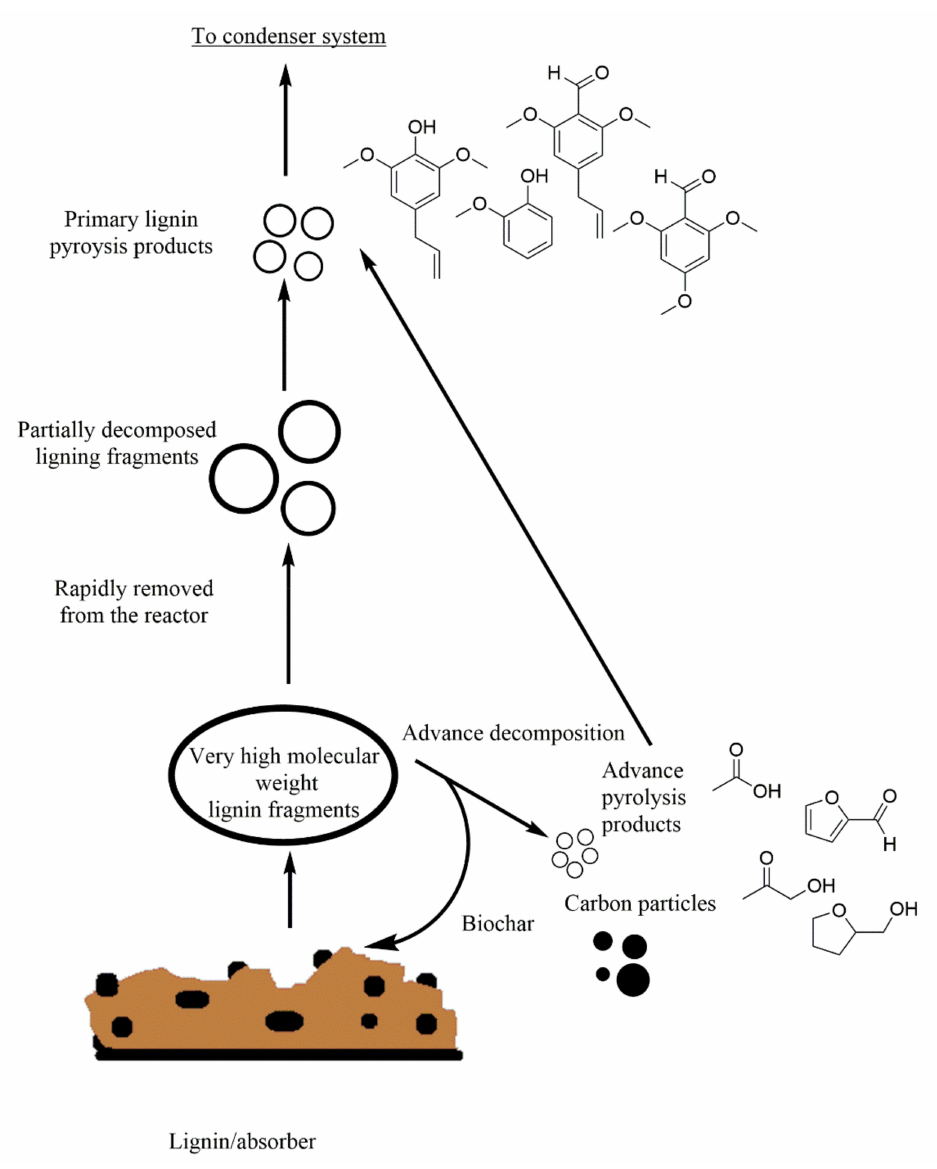
Figure 4. Schematic representation of gas-phase degradation pathways of lignin during reduced pressure MAP as reported by Bartoli et al.